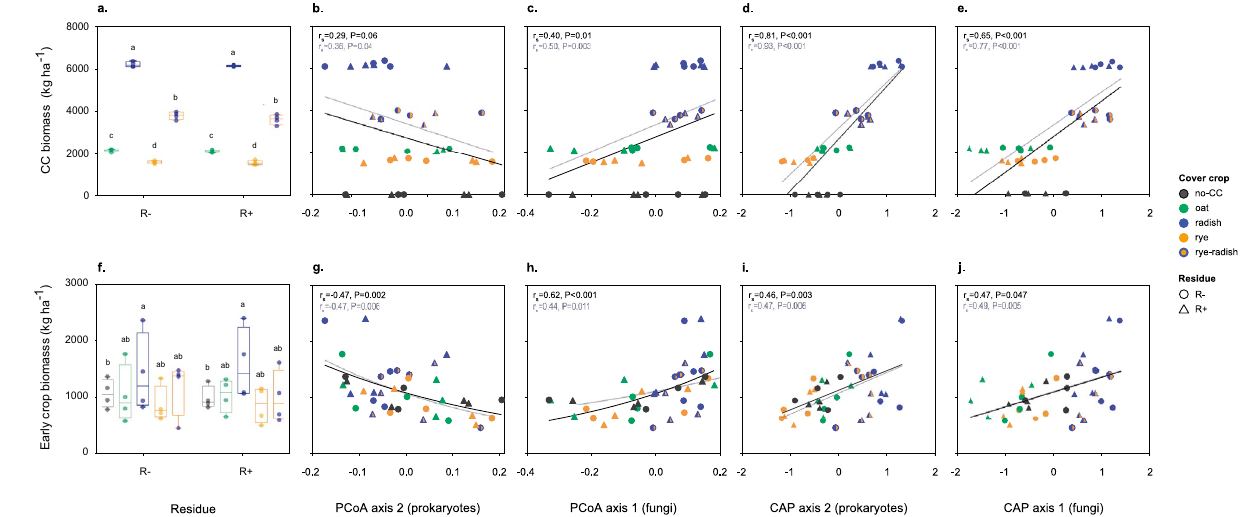
Figure 4. Cover crop (CC) and early tomato aboveground biomass under different CCs and residue management treatments, and relationship between these variables and microbial community composition: ( a ) Response of CC biomass; ( b , c ) Relationship between CC biomass and PCoA axes from prokaryotic and fungal data, respectively; ( d , e ) Relationship between CC biomass and CAP axes from prokaryotic and fungal data, respectively; ( f ) Response of early tomato crop biomass; ( g , h ) Relationship between early crop biomass and PCoA axes from prokaryotic and fungal data, respectively; ( i , j ) Relationship between early crop biomass and CAP axes from prokaryotic and fungal data, respectively. In ( a , f ), different letters show significant differences between CCs for each residue treatment (Tukey test, alpha = 0.05). In ( b – e ) and ( g – j ), Spearman correlations (rs) and trendlines were calculated both including and excluding no-CC (black and grey values/lines, respectively). PCoA and CAP carried out with unweighted UniFrac and Jaccard distances for prokaryotic and fungal communities, respectively. Eigenvalues for prokaryotes PCoA: Axis 1 = 0.094, Axis2 = 0.057; eigenvalues for fungi PCoA: Axis 1 = 0.078, Axis2 = 0.055. CAP results shown in Fig. 2. Symbol colors indicate different CC treatments and R−/R+ refers to main crop residues absent or present, (Fig. 3c). Radish, which had the lowest fungal evenness, presented a high frequency of an unidentified Olpidi- aceae (~ 21%) and, especially in R−, Cercophora sp. (~ 10%) (Fig. 3d). This Olpidiaceae fungus, absent in other CC treatments, was an indicator species for radish (Fig. 3d, Table S5). Contrarily, cereals, but mostly rye, presented higher proportion of Olpidium brassicae (rye R+: 23.47%, rye R−: 7.58%) (Fig. 3d). Retaining crop residues (R+) increased the relative abundance of Glomeromycota and Rozellomycota, as well as lower Zoopagomycota, with some variation between CC treatments (Fig. 2f). Mortierella was a highly abun- dant genus in most samples (14.6–29.4%), and, except for rye, it was more dominant in R+ than R− (Fig. 3d). In no-CC, other taxa were also more dominant in R+ than R−, consistently with the lower evenness: Rozellomycota (3.19% vs . 0.80%), Myrmecridium sp. (3.02% vs. 0.19%), Periconia macrospinosa (3.2% vs. 0.47%), Solicoccozyma terrea (2.61% vs. 1.65%), Acremonium furcatum (3.00% vs. 1.97%), and unidentified Chaetomiaceae (0.62% vs. 0.17%) (Fig. 3c,d).